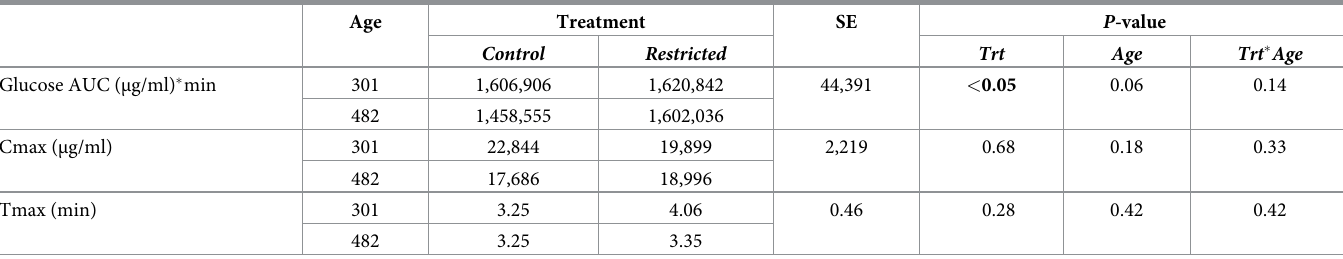
Table 5. Effects of maternal nutritional energy restriction (100% vs 70%) from GD158 to parturition on glucose tolerance of Angus cross offspring at initiation (PND 301; n = 9 per treatment) and end (PND 482; n = 8 per treatment) of ad libitum feed trial.